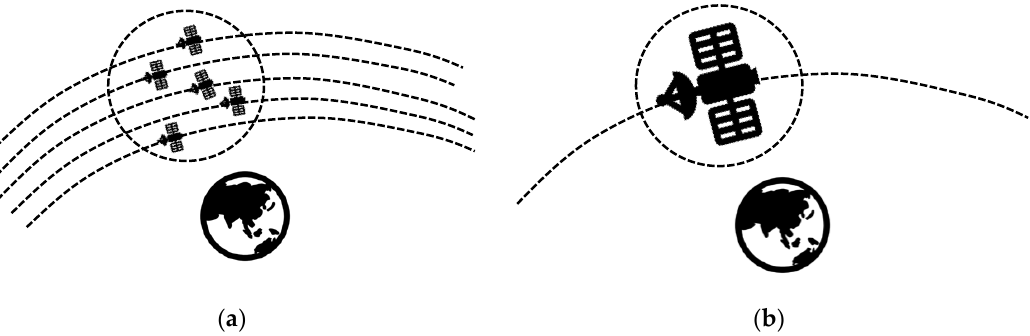
Figure 1. Analyze the movement of the satellite cluster. ( a ) Member satellites in the satellite cluster run on their orbit; ( b ) Regard the satellite cluster as a sizeable virtual satellite.